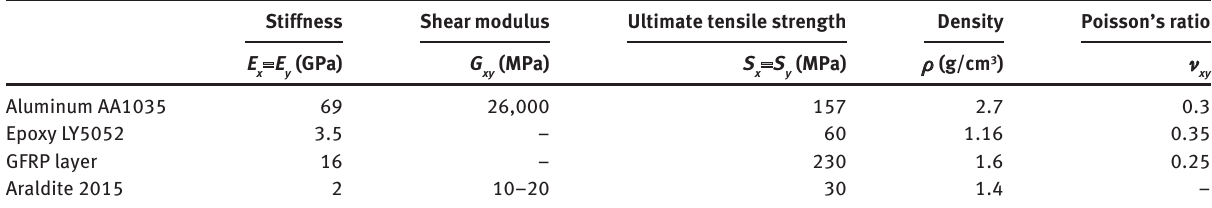
Table 1 Material properties of the aluminum plate, the patches, and the